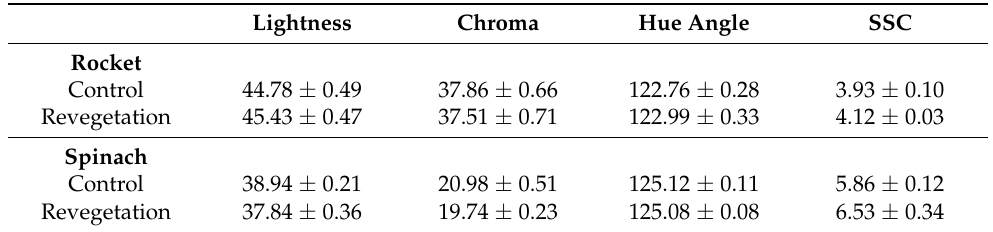
Figure 1. Total leaf mass per area (LMA) ( A , B ) and individual LMA ( C , D ) of rocket ( A , C ) and spinach ( B , D ) baby leaves cultivated in control or revegetation tanks. Means of control and revegetation tanks were computed from three and five harvests, respectively. In ( A , B ), bars ( ± SE) followed by an asterisk are significantly greater ( p ≤ 0.05). In ( C , D ), lines ( ± SE) followed by different letters (upper-case or lower-case) are significantly different ( p ≤ 0.05). Table 2. Colorimetric parameters and soluble sugar content (SSC) of rocket and spinach baby leaves cultivated in control or revegetation tanks. Means of control and revegetation tanks were computed from three and five harvests, respectively. Means ( ± SE) of colorimetric parameters and SSC were calculated from 20 and 3 samples,